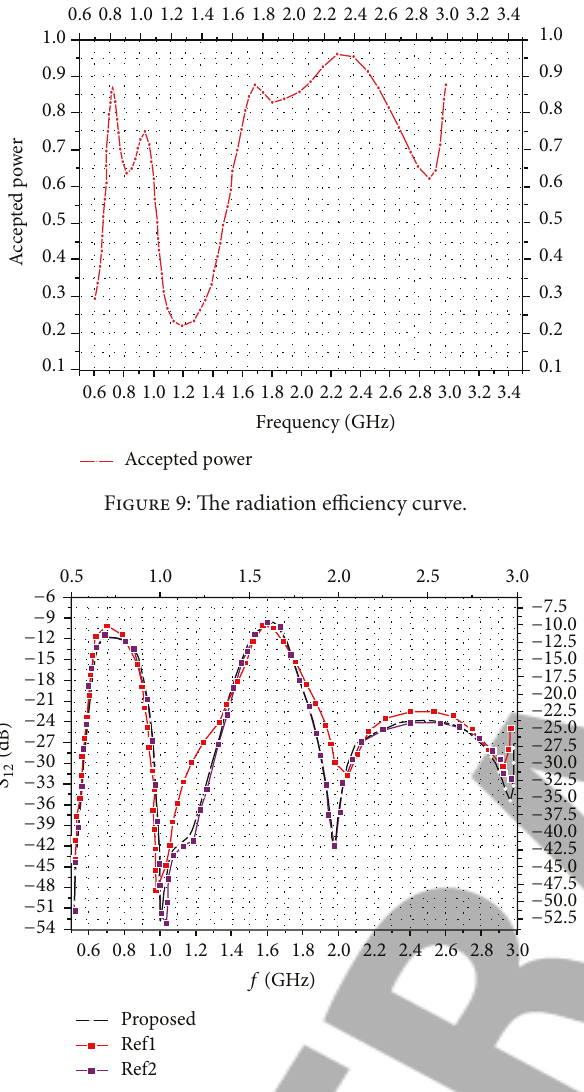
Figure 10: The radiation efficiency curve.